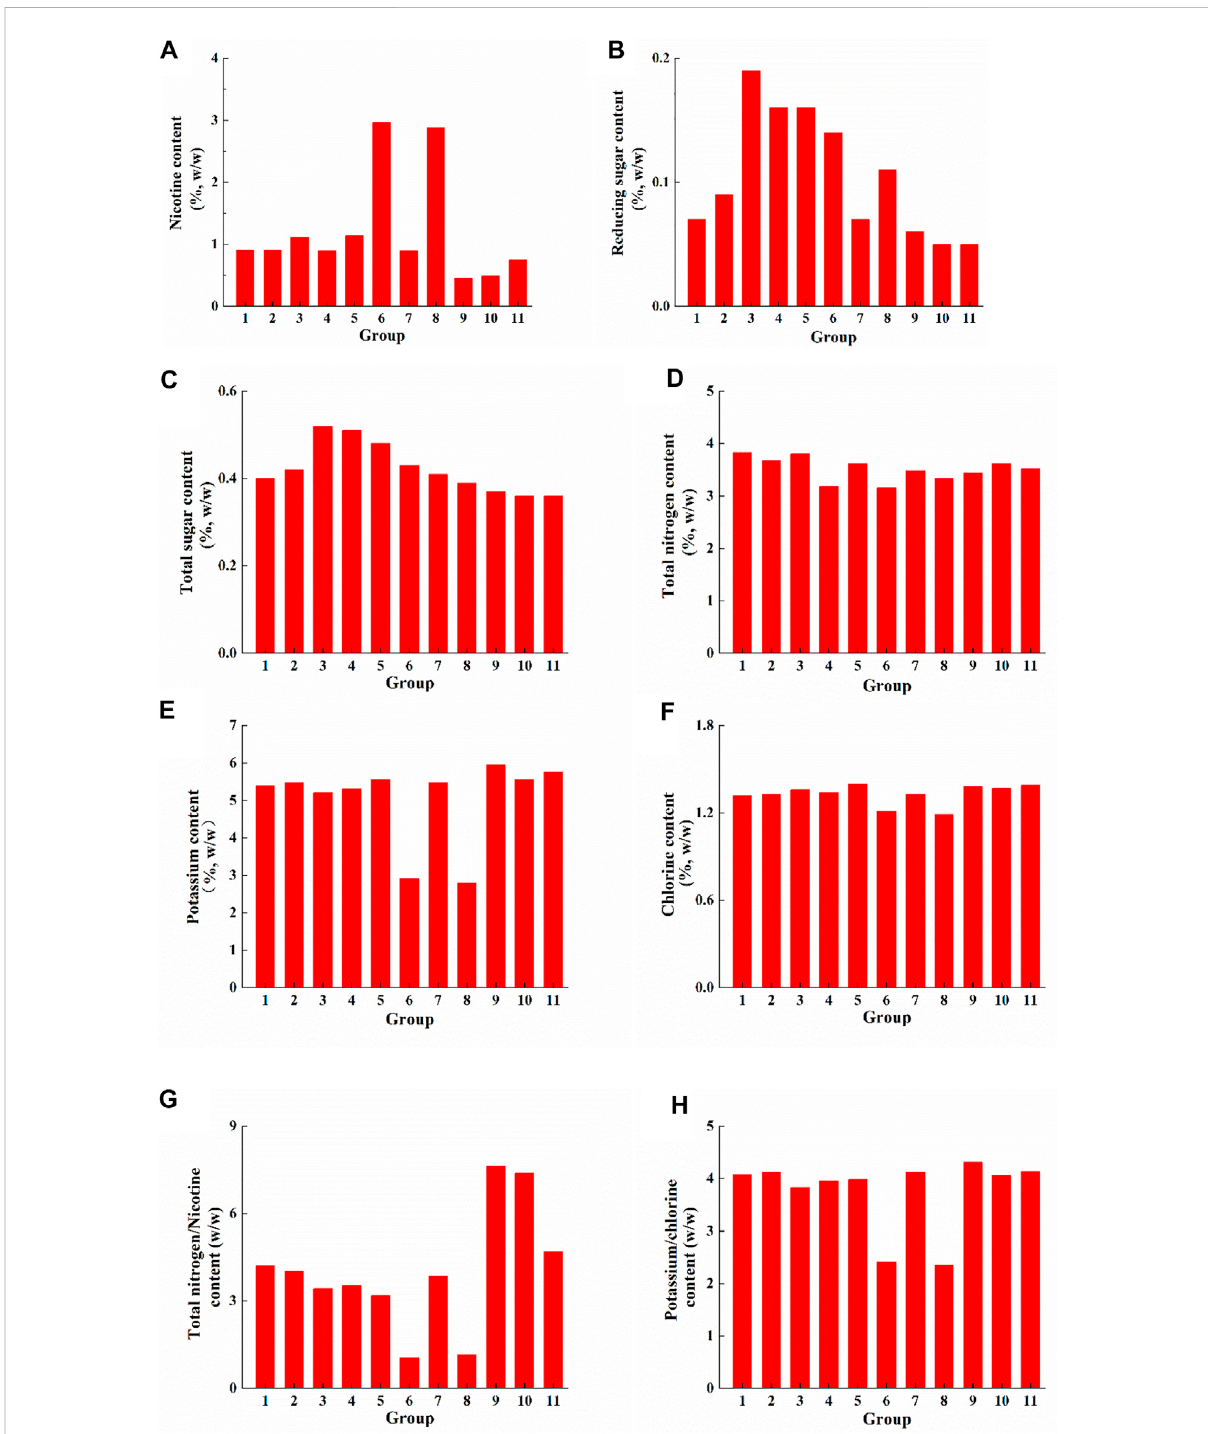
FIGURE 1 Chemical components analysis of cigar fi ller leaves after fermentation. (A) Nicotine content changes; (B) Reducing sugar content changes; (C) Total sugar content changes; (D) Total nitrogen content changes; (E) Potassium content changes; (F) Chlorine content changes. Note: 1-Water; 2-Medium; 3-Medium + Clavispora lusitaniae ; 4-Medium + Saccharomyces cerevisiae ; 5-Medium + Cyberlindnera fabianii 6-Medium + ZygoSaccharomyces rouxii ; 7-Medium + Saccharomycopsis fi buligera ; 8-Medium + Hanseniaspora uvarum J1;